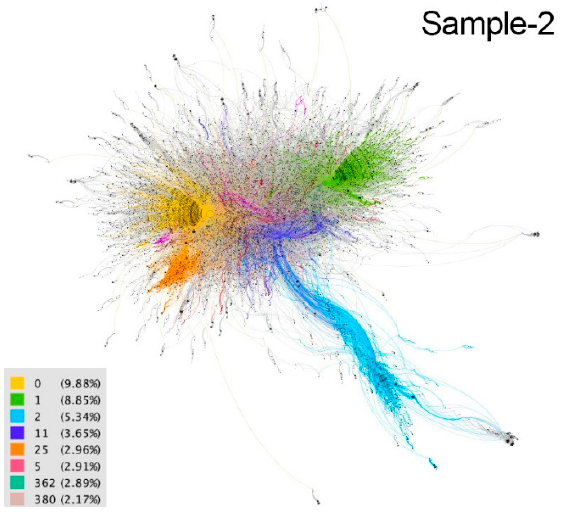
Figure 3. Graph of sample 2. Community detection based on modularity [66] and according to intermediation centrality [63] of sample 1. Source: Gephi [67].